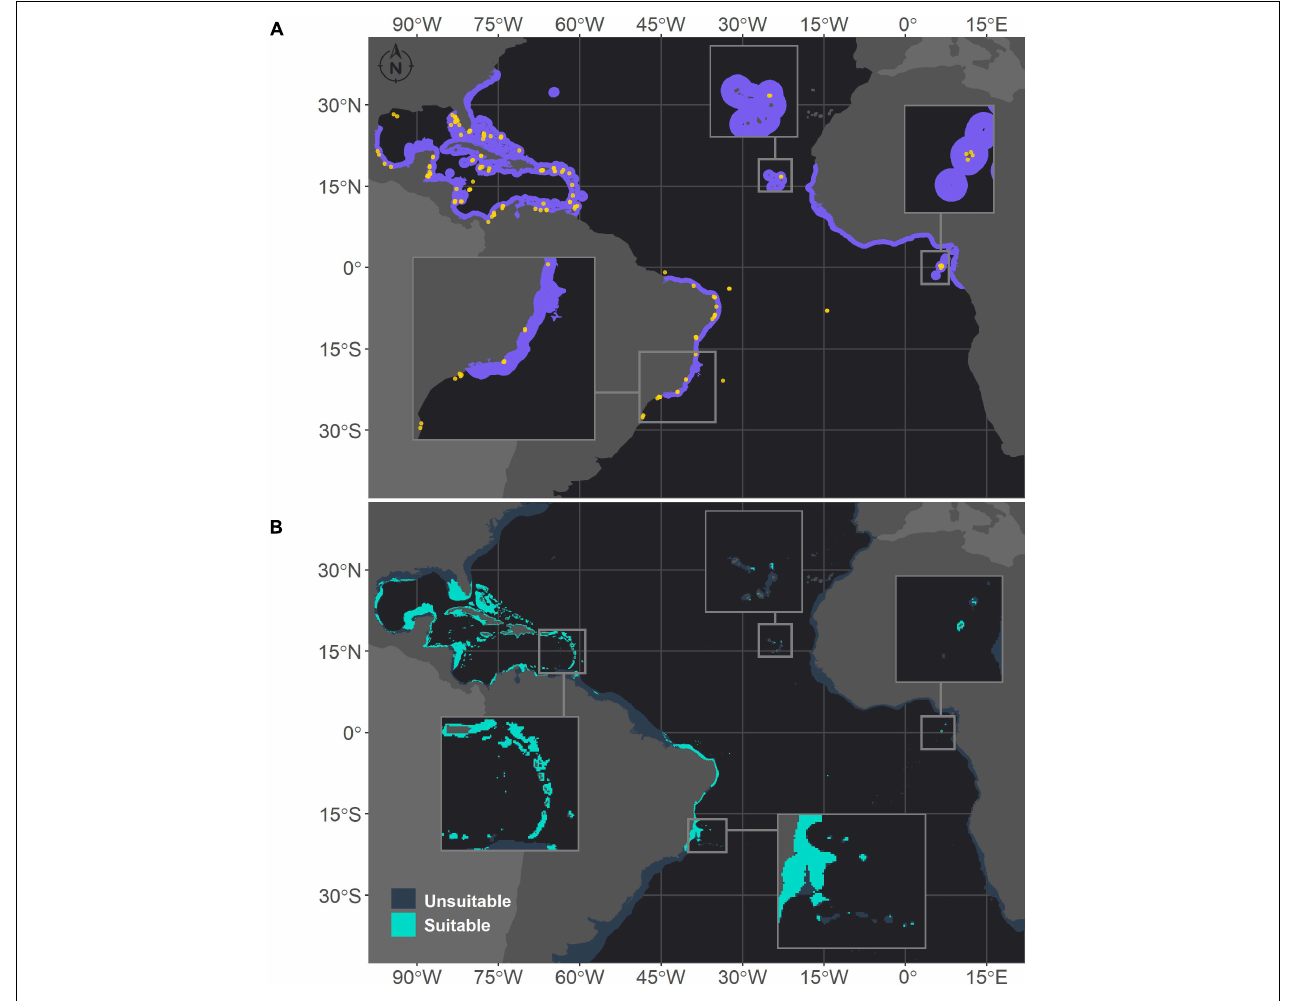
FIGURE 3 | Projected habitat suitability for Siderastrea sp. in the Atlantic, as obtained through an ensemble modeling approach. Map (A) shows the presence points (in orange) used for training the model and shows (in purple) the expected range of Siderastrea according to the IUCN. Map (B) shows the predicted habitat suitability for the current period. In both maps, inset maps highlight the Abrolhos region (left), Cape Verde (top) and São Tomé islands (right), and in map (B) , the top left inset highlights the Caribbean